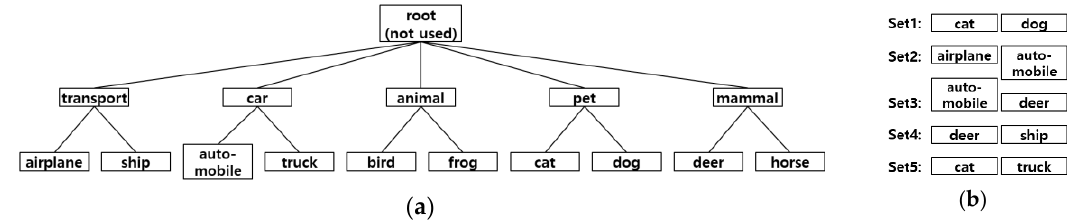
Figure 5. CIFAR-10 hierarchy knowledge and zero-shot category. ( a ) Cifar10 manually constructed hierarchy. ( b ) Zero-shot category sets.